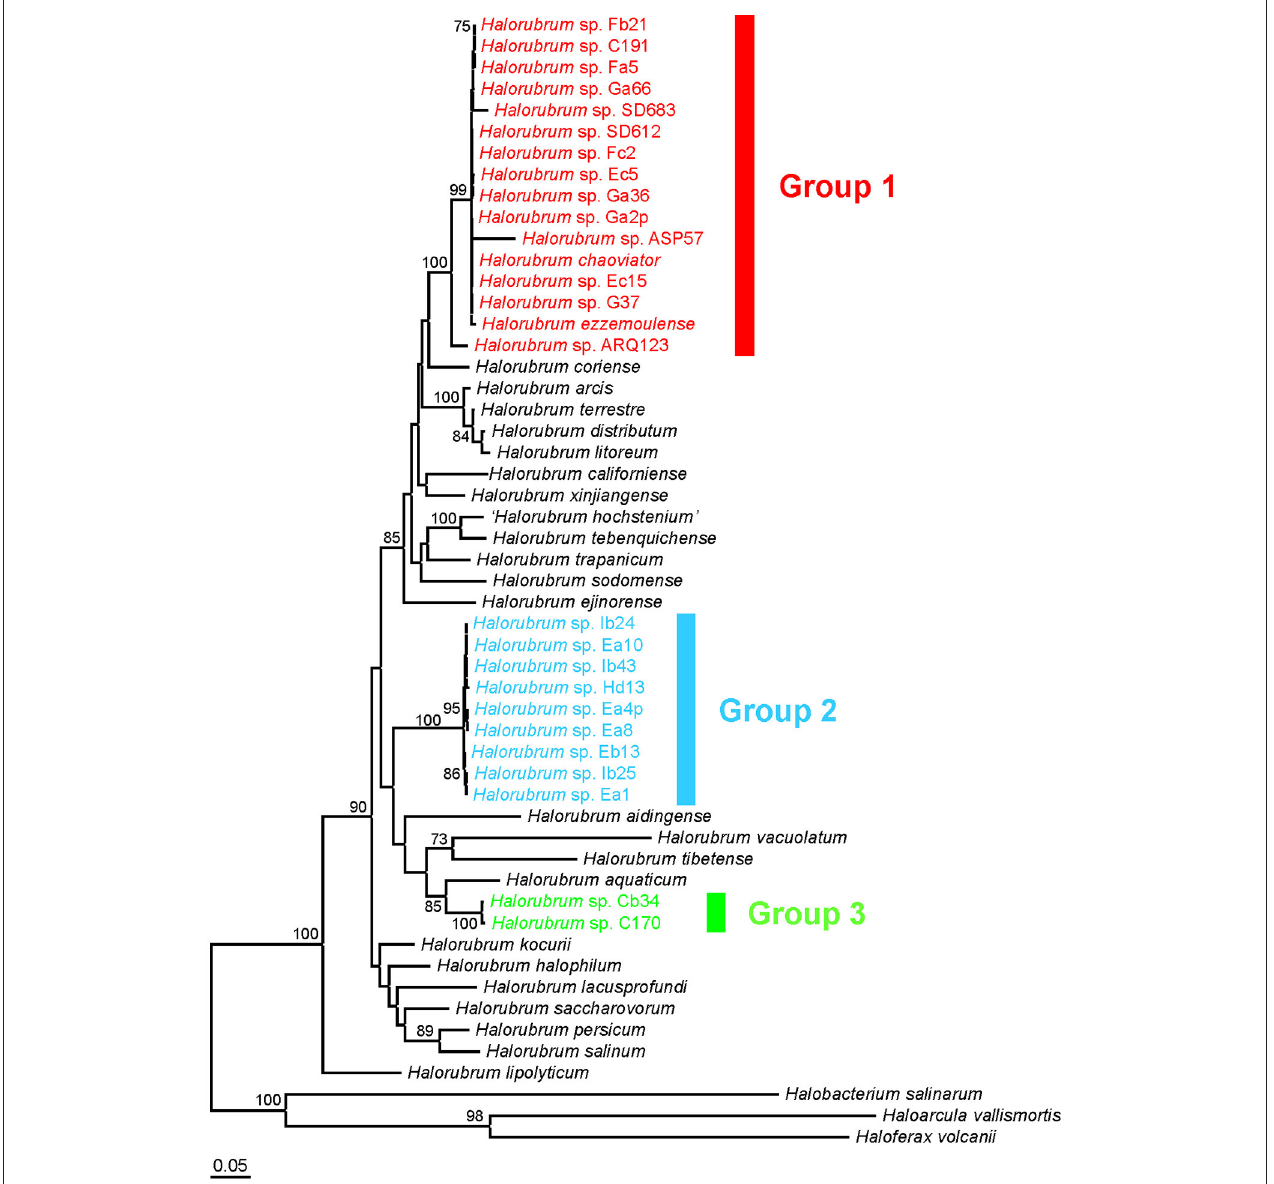
FIGURE 2 | Maximum-likelihood tree based on the five-gene concatenated sequence showing the phylogenetic relationship between members of the genus Halorubrum and strains isolated in this study. The accession numbers of the sequences used are shown in Table S1. Bootstrap values > 70% are indicated. The species Haloarcula vallismortis , Haloferax volcanii, and Halobacterium salinarum were used as outgroups. The scale bar represents 0.05 substitutions per nucleotide position. Different phylogroups have been marked with different